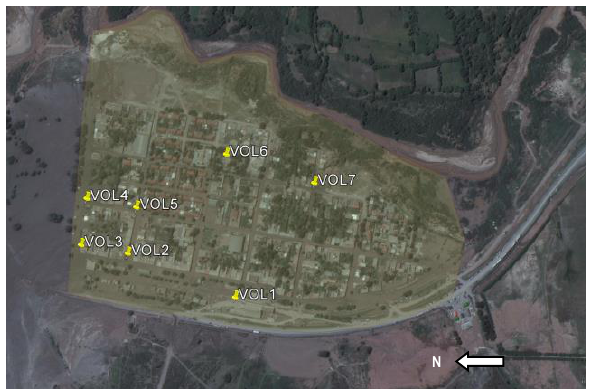
Figure 2. Area under study and GCP locations © 2018 DigitalGlobe (Google Earth) 3.2 Ground Control Points (GCPs)